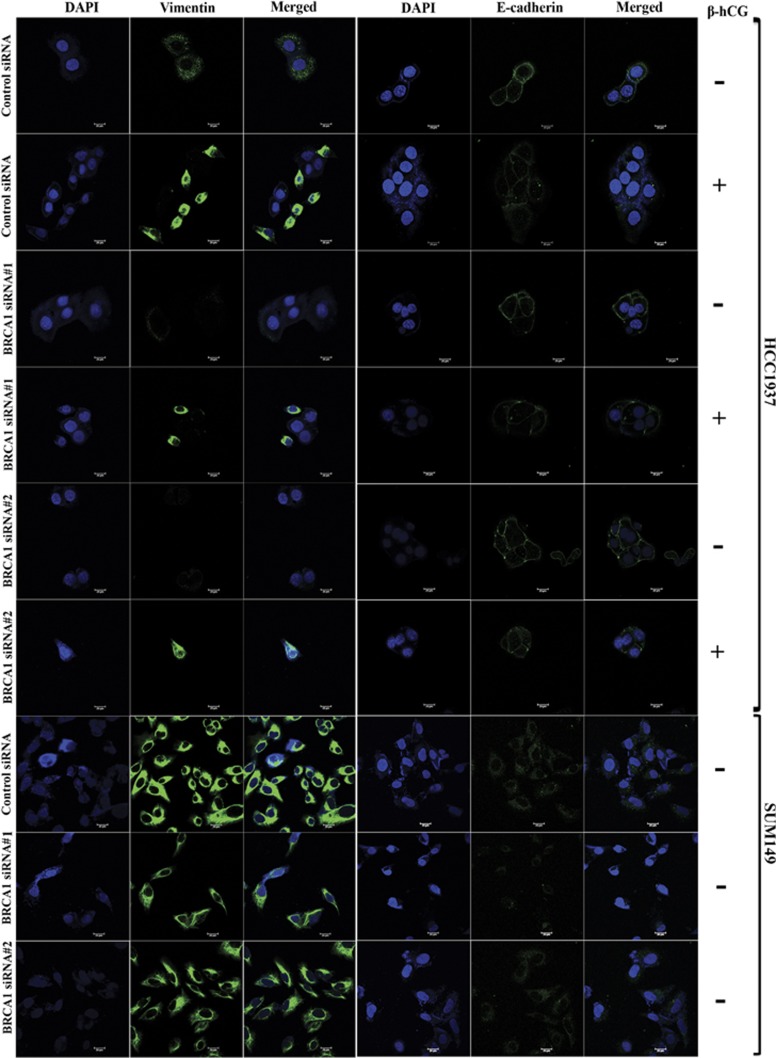
Mutant BRCA1 augments β-hCG induced EMT in BRCA1 defective cells. Immunoflourescence analysis of Vimentin and E-cadherin in control silenced (control siRNA) and BRCA1 silenced (BRCA1 siRNA#1 and BRCA1 siRNA#2) HCC1937 and SUM149 cells. “−” represents β-hCG unsupplemented cells and “+” represents exogenous β-hCG supplementated cells.